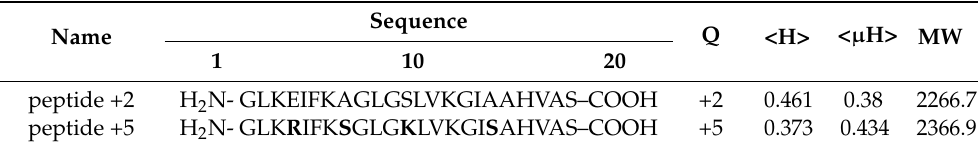
Table 1. Peptide sequences and properties.